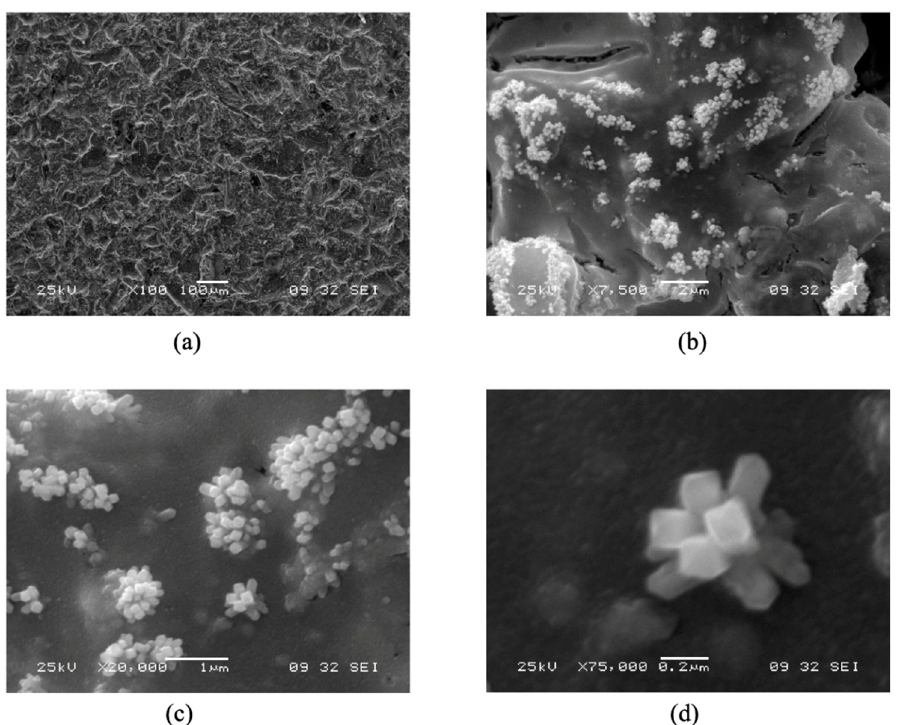
Figure 1. Varying magnification SEM images of RuO 2 nanorods grown on a mixed metal oxide ribbon mesh anode. ( a ) RuO 2 nanorods grown on MMO at 100 × magnification, ( b ) RuO 2 nanorods grown on MMO at 7500 × magnification, ( c ) RuO 2 nanorods grown on MMO at 20,000 × magnification, and ( d ) RuO 2 nanorods grown on MMO at 75,000 × magnification